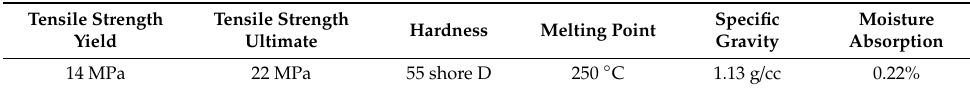
Table 1. Material properties for thermoplastic polyurethane (TPU) flexible filament as received from the supplier.